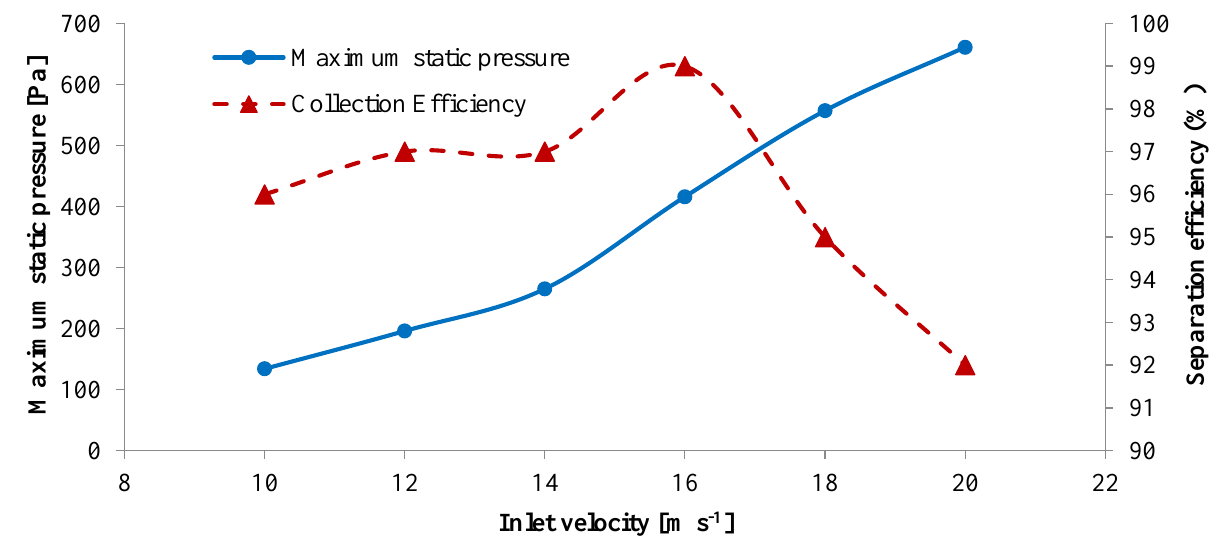
Figure 17. Maximum static pressure and separation efficiency in various inlet velocities.